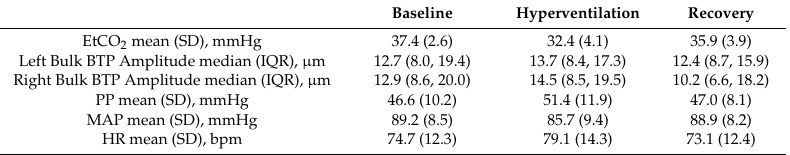
Table 1. Hyperventilation for 90 s successfully reduced EtCO 2 by − 5.0 mmHg and generated significant transient perturbations in PP, MAP and HR. Some evidence of an impact of hyperventilation on BTPs was found when inspecting trends, and a significant drop in BTP amplitude was noted for the right and left hemispheres in the recovery phase. A summary of the results of hypothesis tests comparing hyperventilation phases with baseline and recovery is provided in Figure